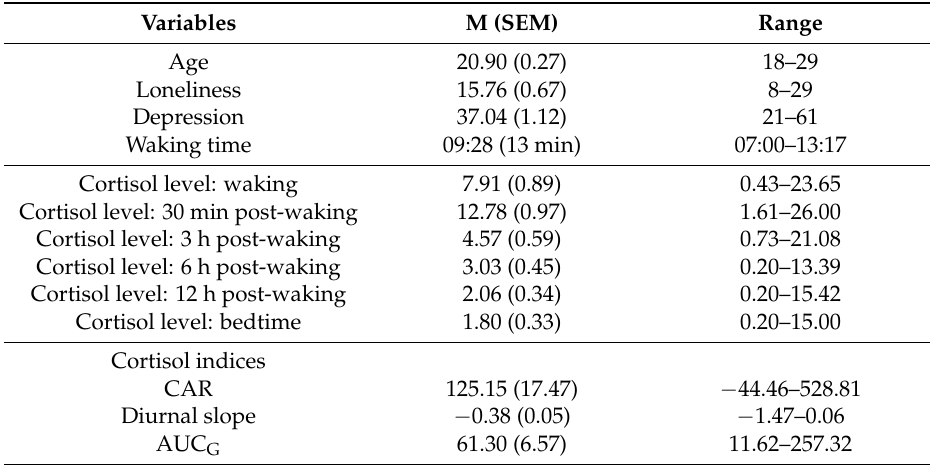
Table 1. Means (SEMs) of Sample Characteristics and Cortisol Indices.